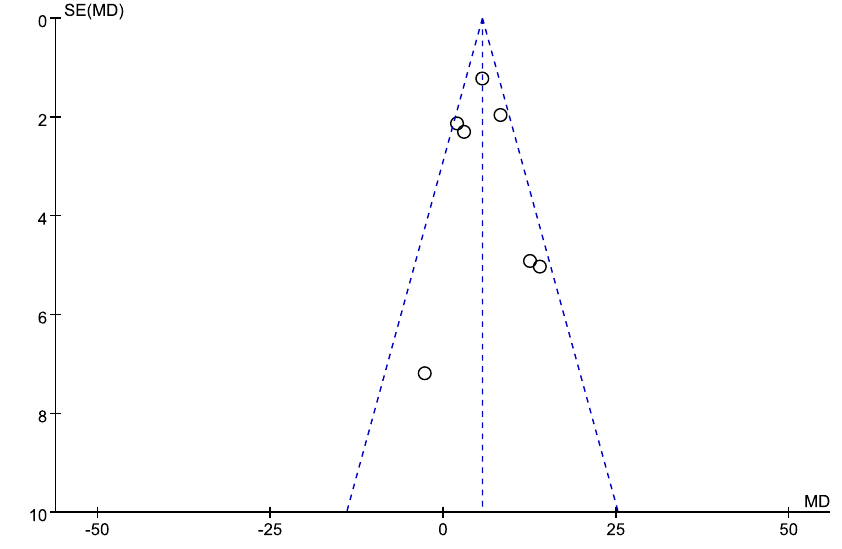
Figure 2. Funnel plot for necrotic core volume outcome data of involved studies.